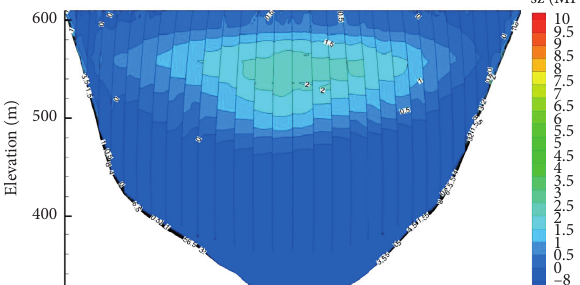
Figure 20: Envelope of maximum static and dynamic vertical stress distribution of upstream surface of the dam for no-slip